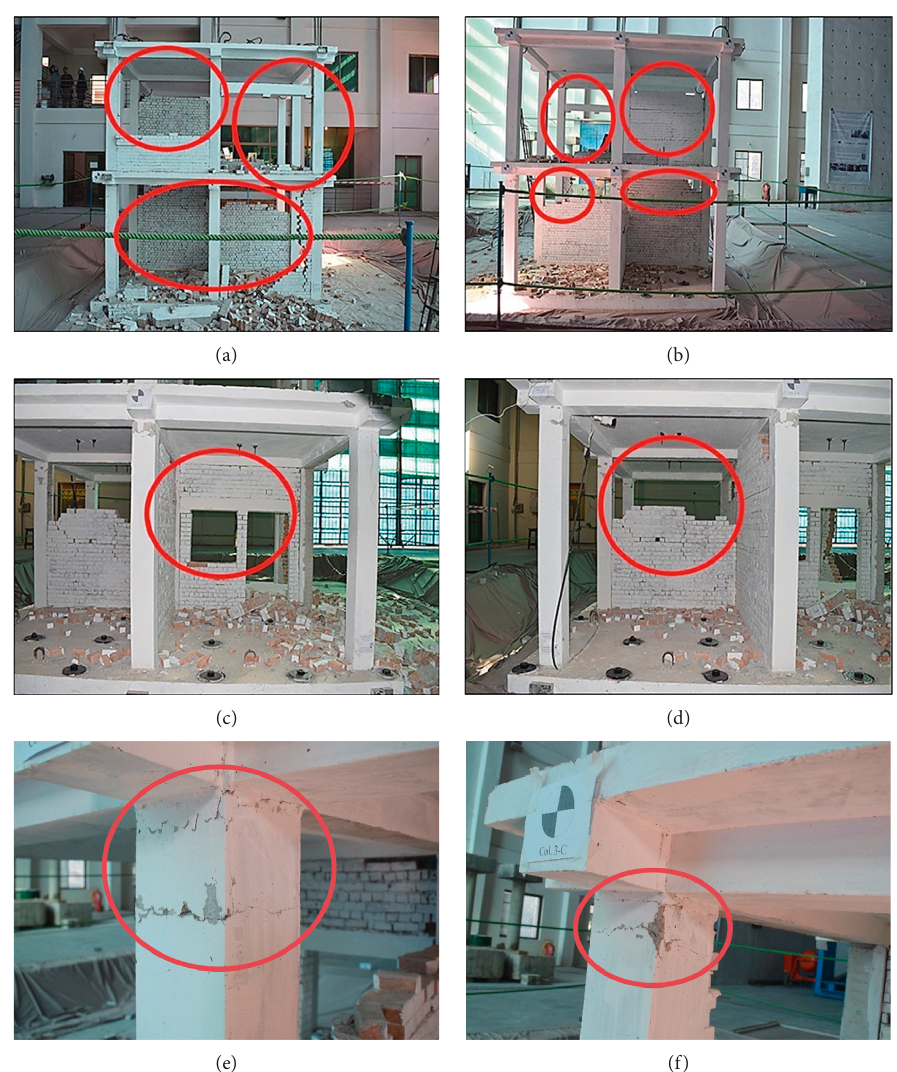
F IGURE 15: Damage observations of URM walls after Test Run-3. (a) West face of the test specimen. (b) East face of the test specimen. (c) South face west-side infilled frame. (d) South face east-side infilled frame. (e) Crack at the top of the exterior column. (f) Crack at the top of the exterior